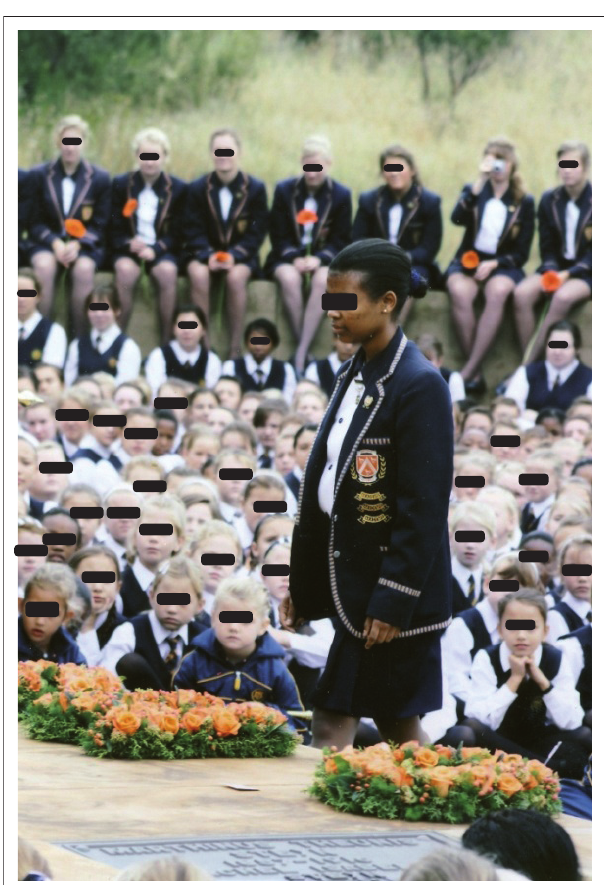
FIGUUR 9: Emme-Lancia Faro, vorige hoofmeisie van Oranje, lê ŉ krans by die